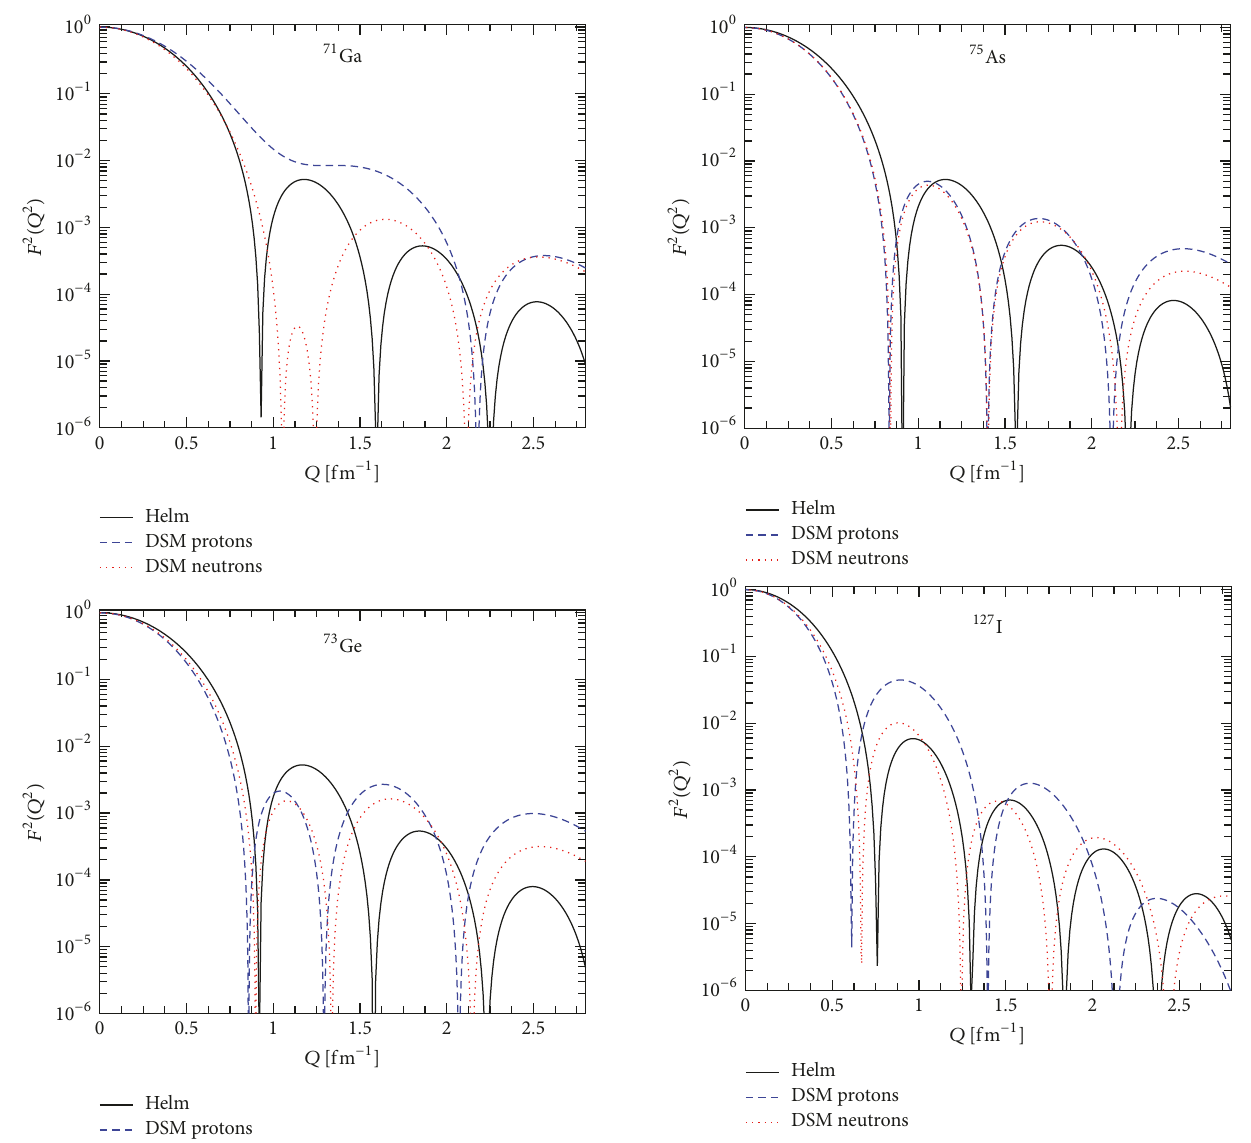
Figure 5: Same as in Figure 4 but for the 75 As and 127 I